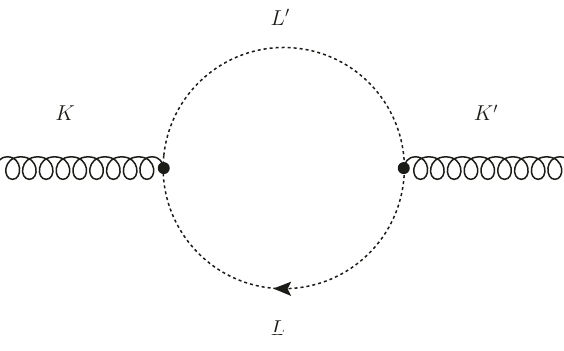
Figure 4 . The ghost loop contribution to the gluon